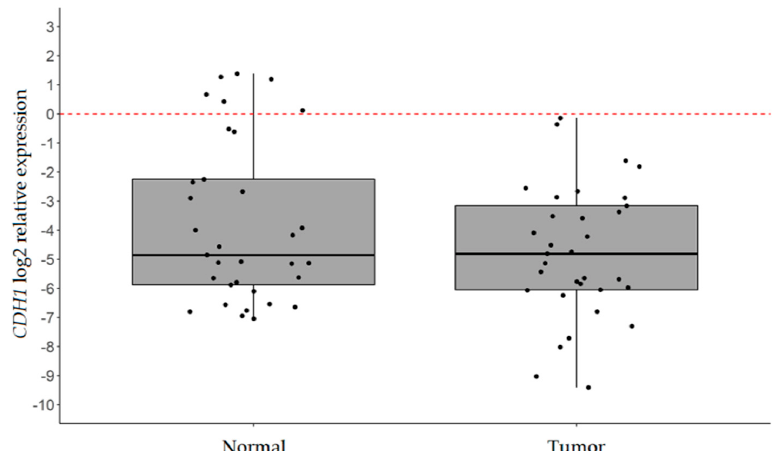
Figure 1. CDH1 expression analysis by real-time (RT)-qPCR. Box plots of the log2 relative expression (2 − ∆ Ct ) of CDH1 in neoplastic and matched normal tissues of 33 IGC patients. B2M was used as the internal control. p -value = 0.025 (paired student’s t -test). 2.2. Explorative Analysis Suggests that the Expression of miR-101, miR-26b, and miR-200c is Altered in IGC